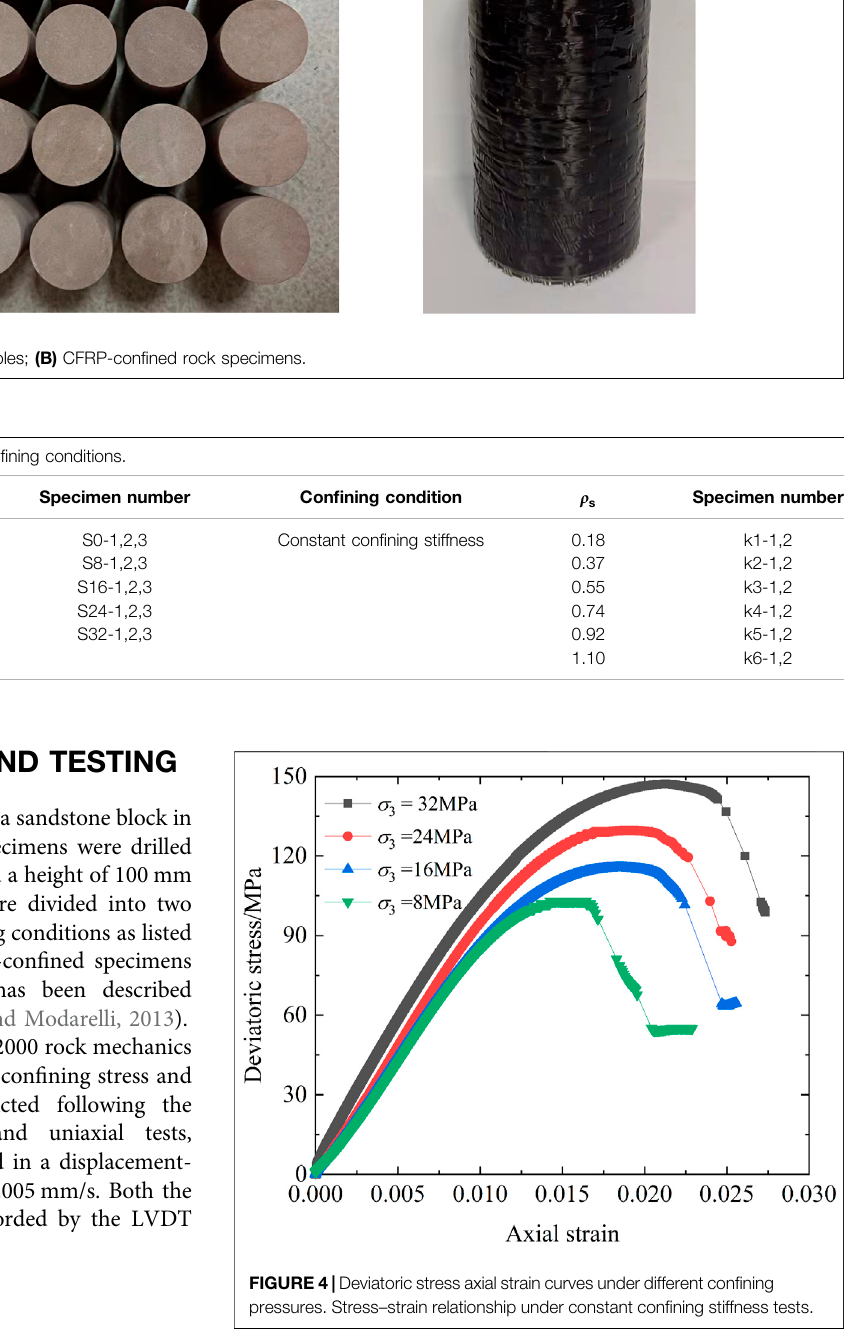
Frontiers in Earth Science |